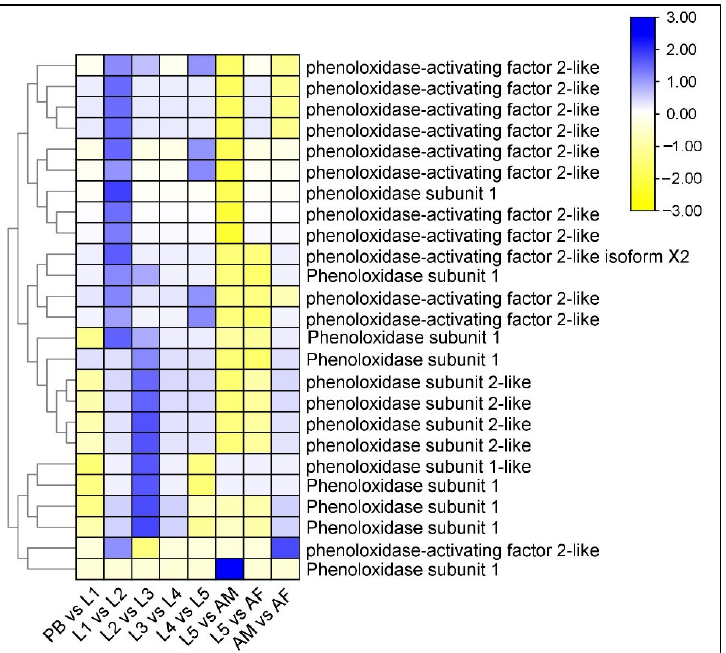
Figure 4. Identification of DEGs of Phenol oxidases in P. bremeri transcriptome. Heatmap representation of the differentially expressed genes of phenol oxidases.